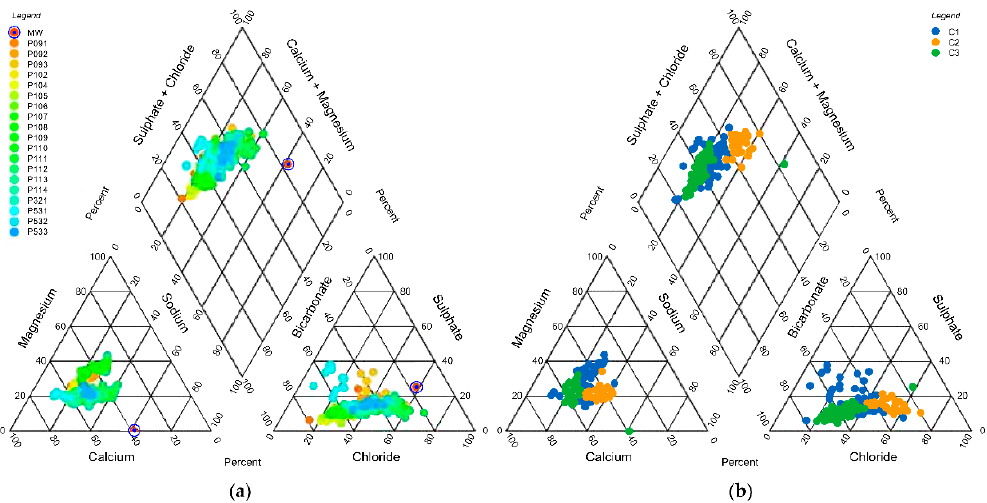
Figure 9. Piper diagram of the data. The diagram on the left is grouped by well ( a ). The diagram on the right is grouped according to the SOM clustering results ( b ). MW represents the meteoric water of the area [38].